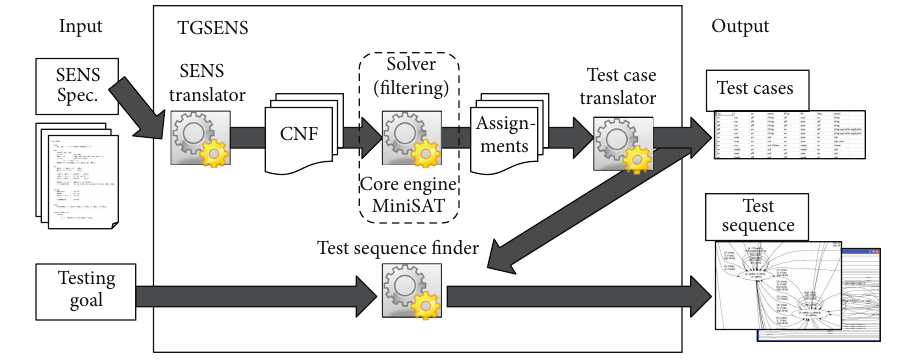
Figure 2: An overview of TGSENS